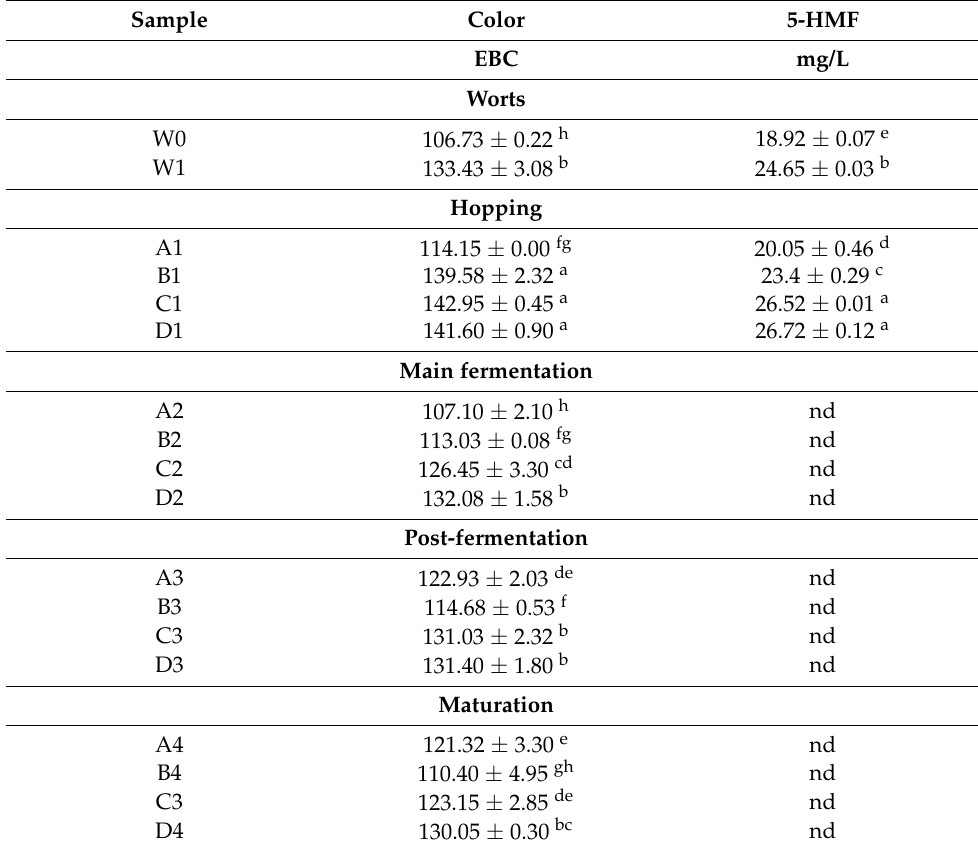
Table 4. Color (EBC) and 5-hydroxymethylfurfural (5-HMF) content in worts and